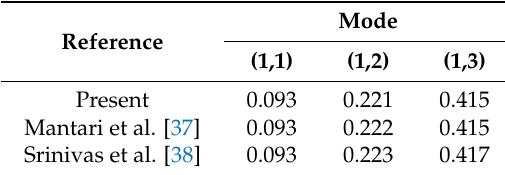
Table 3. Dimensional frequency parameter of the simply supported square isotropic plate.